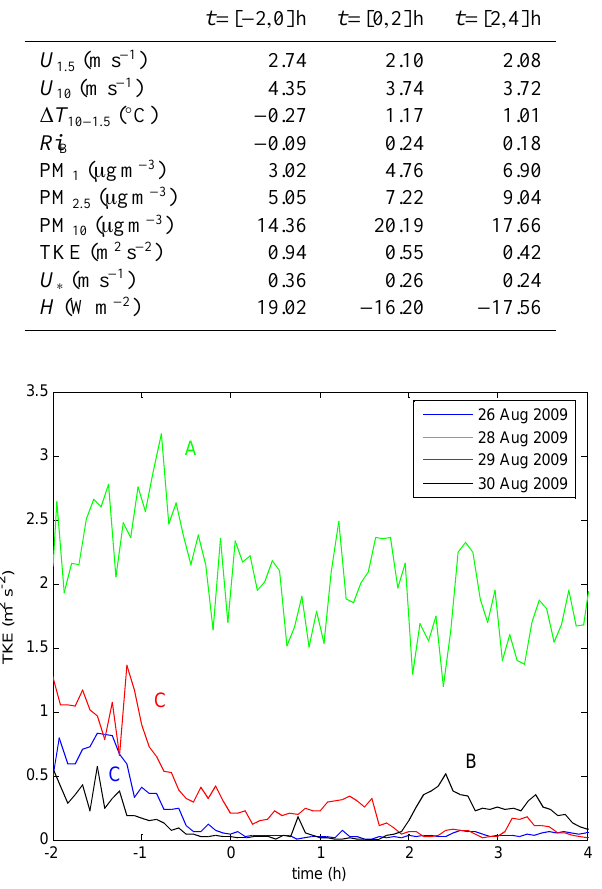
Figure 1. Observed TKE evolution at 10m for di ff erent types of evening transitions (A, B, C). Times are normalized around sunset for each day ( t sunset = 0h).